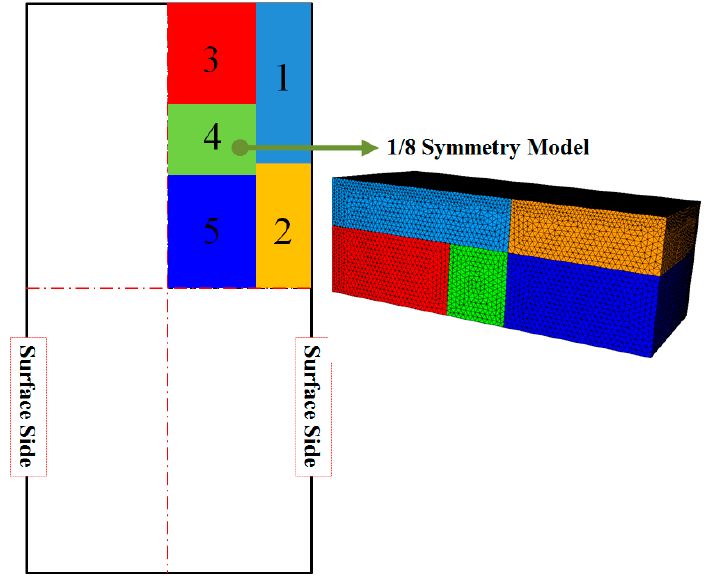
Figure 4. One-eighth model discretization with multiple materials in which cross section A-A indicates five zones with respect to the outer and symmetry planes.